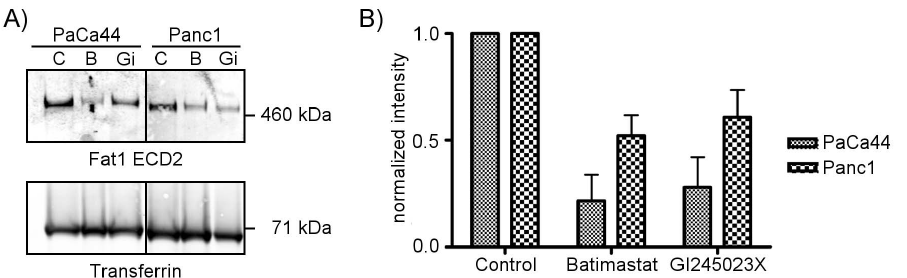
Figure 5. Metalloproteases are involved in Fat1 ectodomain shedding. The figure in A) shows a representative Western blot. PaCa44 and Panc1 cells were incubated in serum free medium for two days with the addition of either the broad spectrum metalloprotease inhibitor Batimastat (B, 10 m M), or the ADAM10-specific inhibitor GI245023X (GI, 5 m M) or solvent as a control (C, DMSO). Secretomes, 8 m g protein per sample, were analyzed by Western blot analysis using the Fat1 ECD2 polyclonal antibody. Blotting against transferrin was used as a loading control. (B) Fat1 specific signals from three independent experiments were quantified and normalized with the transferrin signals. The bar graphs show the mean values + / 2 S.E.M. from three experiments.